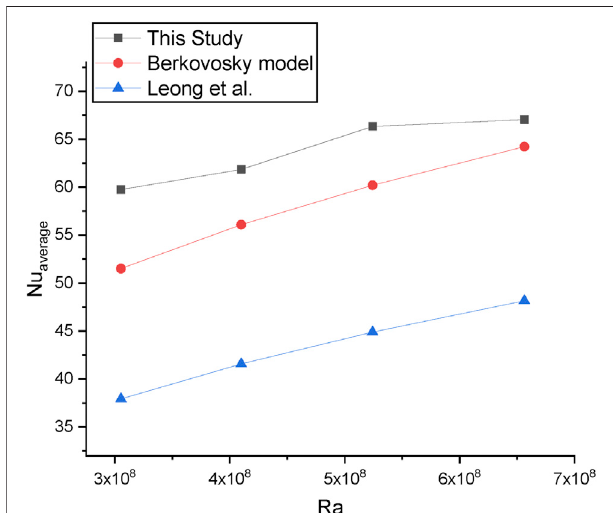
FIGURE 9 | Cavity